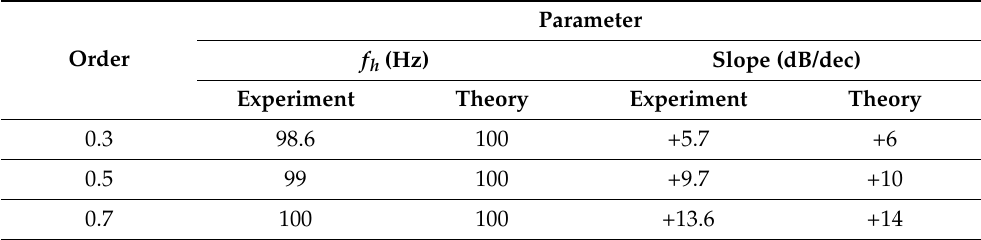
Table 5. Frequency characteristics of the HP filter responses in Figure